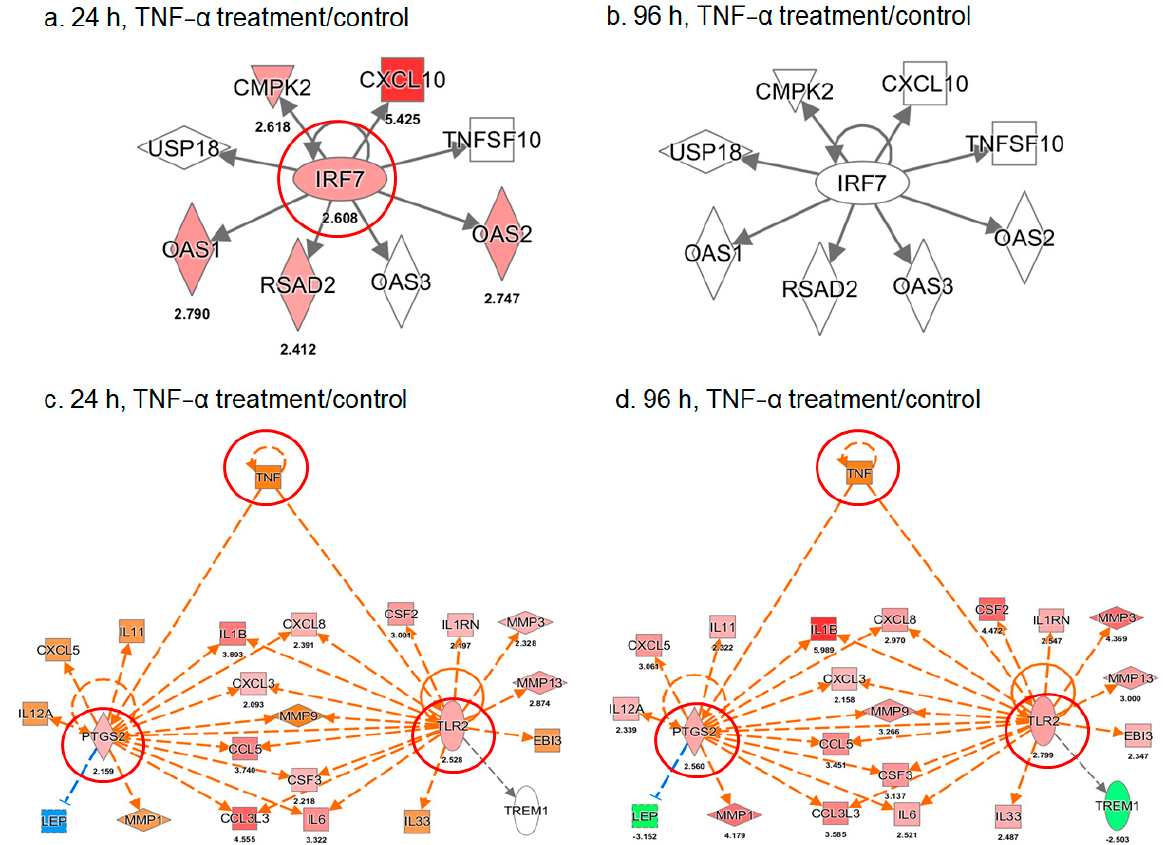
Figure 6. Effect of TNF- α treatment on IRF7-regulated gene expression ( a , b ) and TLR2- or PTGS2-mediated pathways ( c , d ) in ADSCs. A putative signaling network for the expression of genes that responded to TNF- α stimulation of ADSCs for 24 and 96 h were proposed using the Ingenuity software. The red and green symbols indicate up- and downregulated gene expression, respectively, while the orange and blue symbols represent nonresponsive genes; however, they were predicted as activated and inhibited molecules in these networks. The number under each symbol indicated on the maps is the ratio fold change between the treatment and control